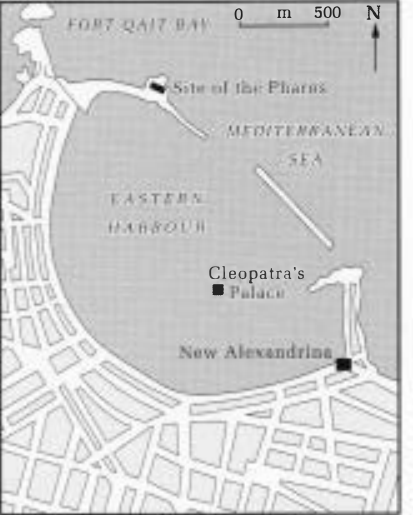
Figure 1 Fort Qait Bay, showing the loca­ tion of the underwater sites mentioned in the text and of the New Alexandrina